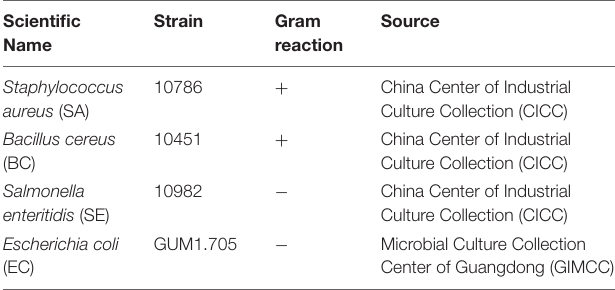
TABLE 1 | Common bacteria used in this